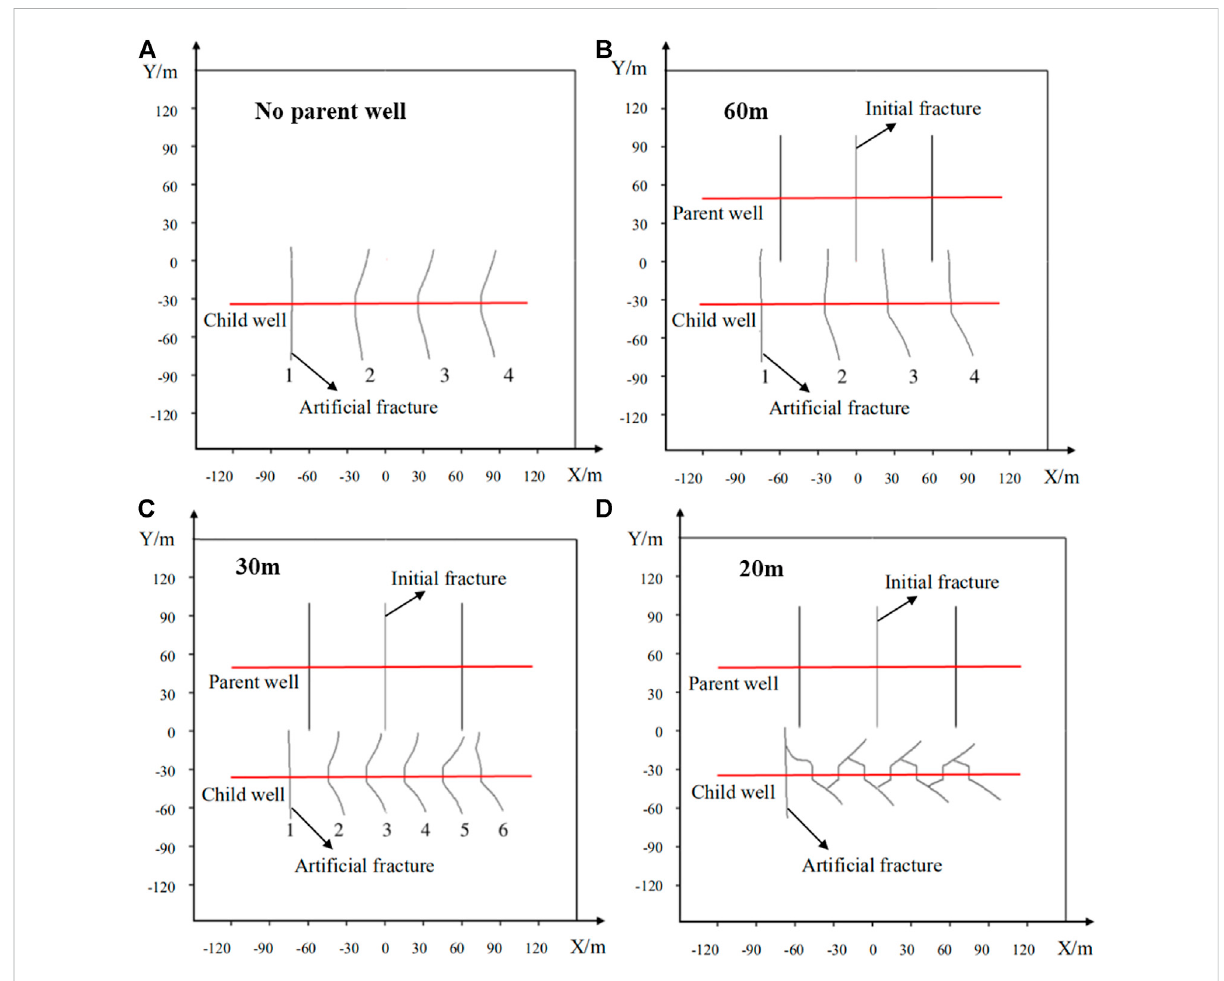
FIGURE 9 Hydraulic fracture propagation trajectories under different fracture